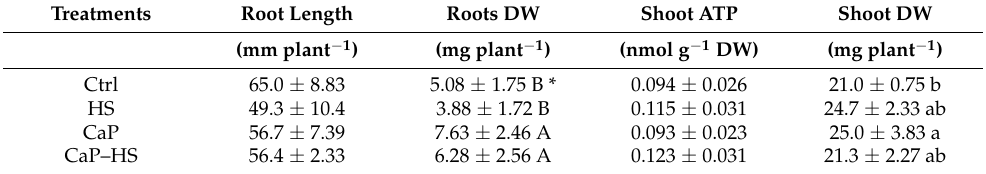
Table 2. Seedling root length, root, and shoot dry weight, and ATP concentration in shoots of Diplotaxis tenuifolia . Data are expressed as mean ± standard deviation (n = 4). Different letters indicate statistically significant difference between treatments at Tukey’s post-hoc test ( p ≤ 0.05).